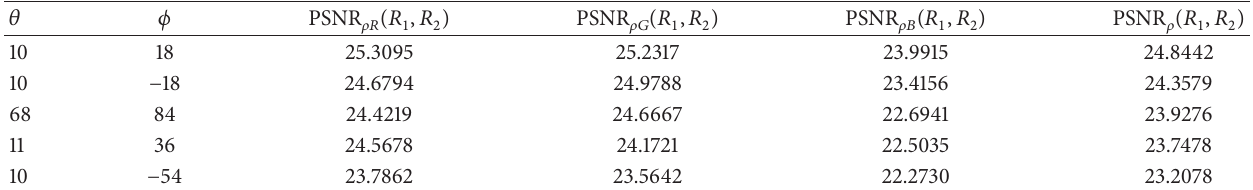
Table 4: Best PSNR from the F-transform based method with 𝐿 = 255 and 𝜌 = 0.006944 for the pen image dataset obtained from the comparison with the sample image at 𝜃 = 10 ∘ and 𝜙 = 54 ∘ .